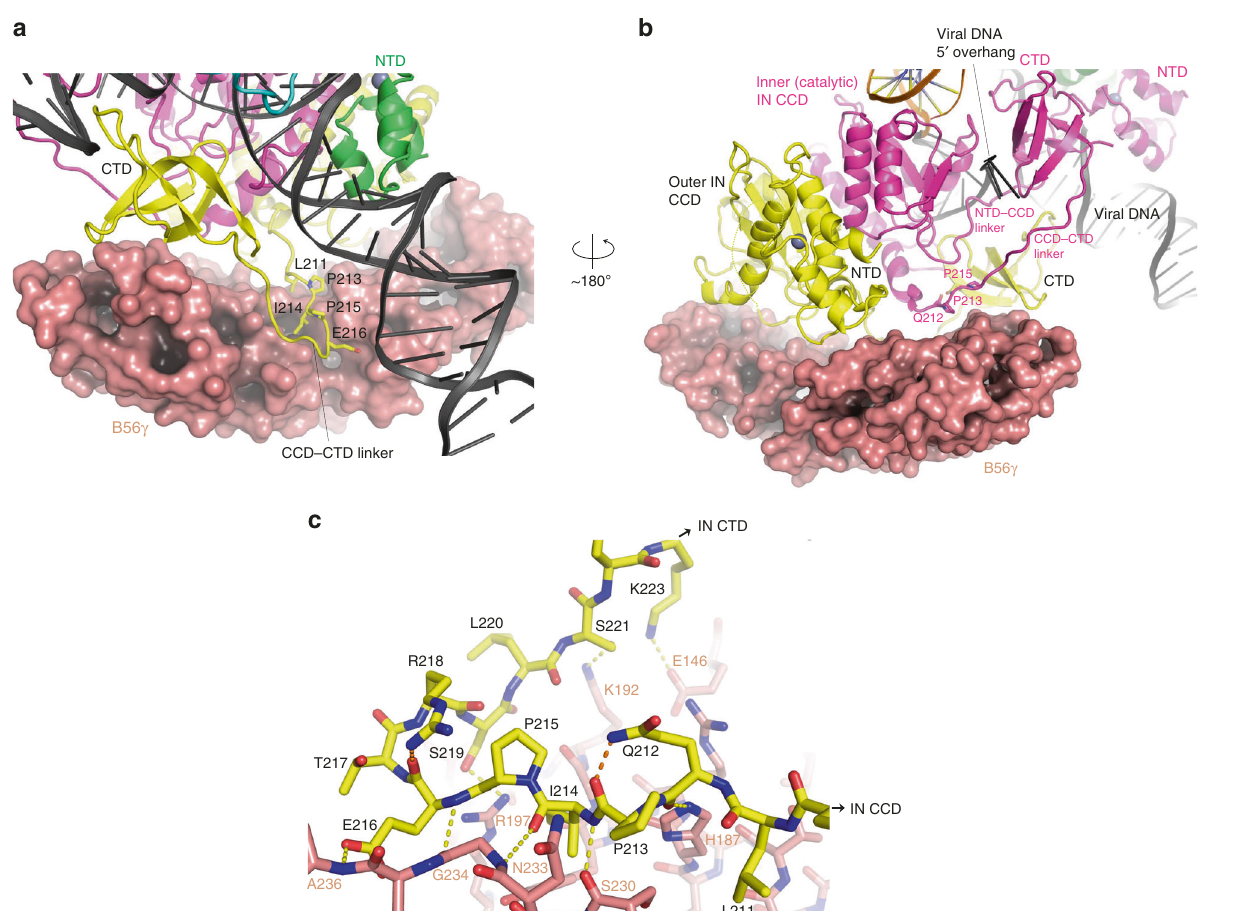
Fig. 2 B56 γ – IN interface. a A close-up view centered on the CCD – CTD linker of outer non-catalytic IN (yellow) containing the 211 L QP I P E 216 short linear motif, which is docked in the central cleft of B56 γ . Molecular surface is shown for B56 γ . b A view from the opposite side of B56 γ . The CCD – CTD linker of inner catalytic IN (magenta) traverses the B56 γ surface. c A network of hydrogen-bonds and salt-bridges mediating the binding of IN CCD – CTD linker in a U-shaped conformation to B56 γ . Intermolecular and intramolecular contacts are highlighted by yellow and orange dotted lines,